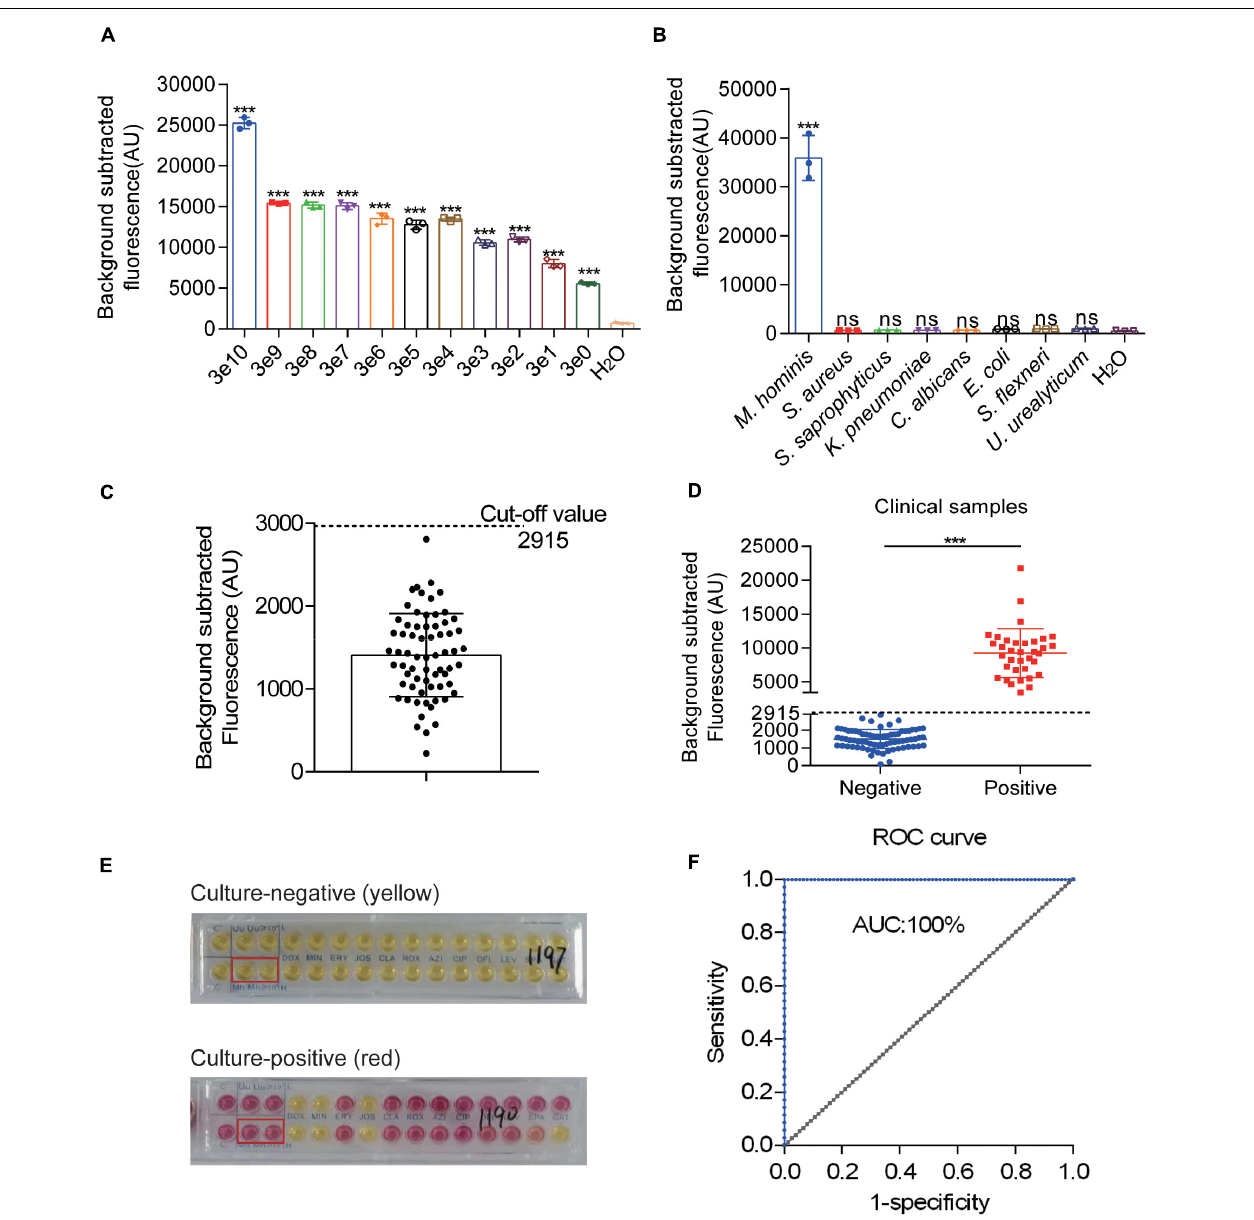
FIGURE 4 | Evaluation and clinical assessment of RPA-CRISPR-Cas12a-fluorescent assay (RPA-Cas12a-Fluo). (A) Fluorescent results of the pMD19-T-MH gap detected by the RPA-Cas12a-Fluo assay with different copies. (B) Fluorescent results of different urogenital pathogens detected by the RPA-Cas12a-Fluo assay. (C) Fluorescent results of 67 clinical M. hominis- negative specimens detected by the RPA-Cas12a-Fluo assay. (D) Fluorescent results of 111 clinical samples detected by the RPA-Cas12a-Fluo assay. (E) Liquid medium culture results of negative and positive samples. (F) ROC curve of RPA-Cas12a-Fluo assay for detecting M. hominis when taking the liquid culture results as the standard. The data are presented as the mean ± SD from three independent experiments. *** p < 0.001. gap, glyceraldehyde-3-phosphate dehydrogenase; S, sample; T line, test line; C line, control line; ROC, receiver operating characteristic curve; AUC, area under the curve.